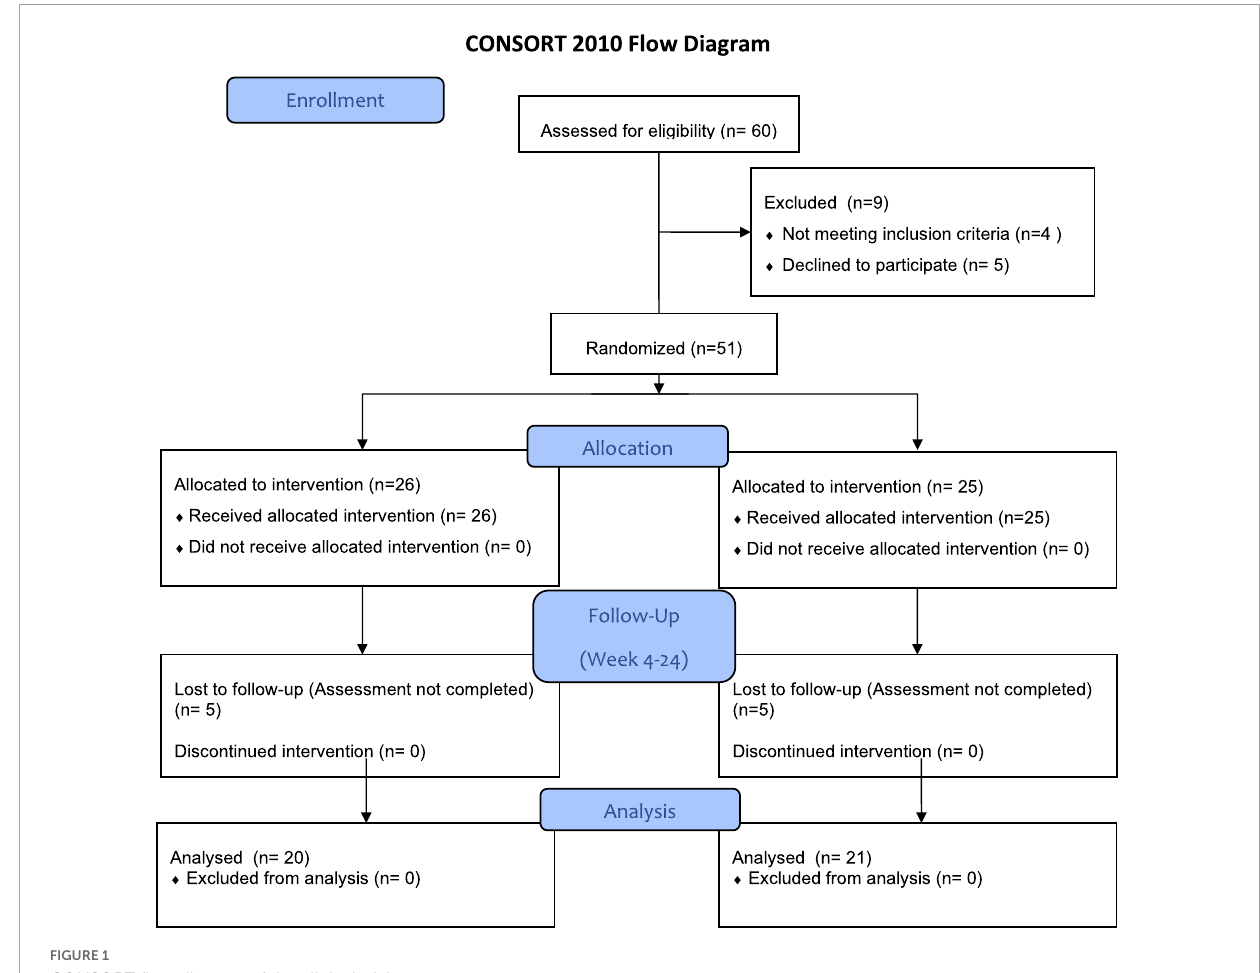
FIGURE1 CONSORT flow diagram of the clinical